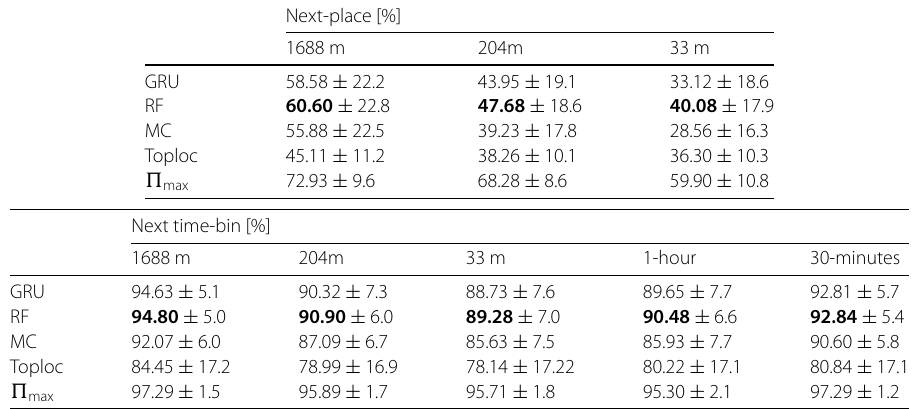
Table 3 An average accuracy of four prediction algorithms and theoretical upper bound of predictability calculated for the two types of mobility sequences of various spatio-temporal resolution Next-place [%] 1688